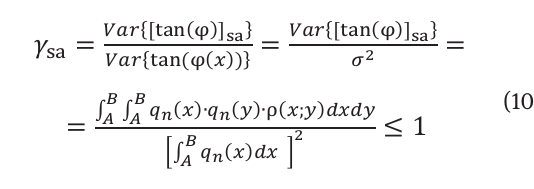
Figure 2: The dimensionless variance reduction factors g depending on the correlation parameter d (m) and the stress parameter S